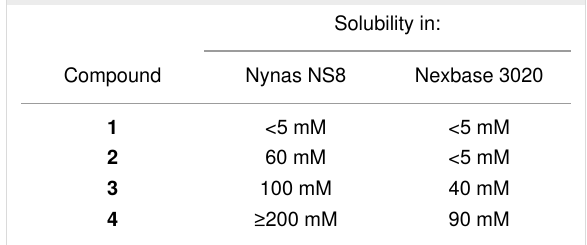
Table 1: Maximum concentration of each compound in Nynas NS8 and Nexbase